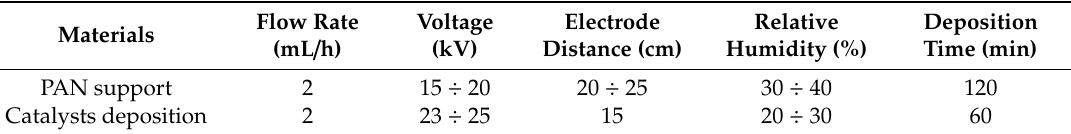
Table 1. Process parameters for the membranes production.